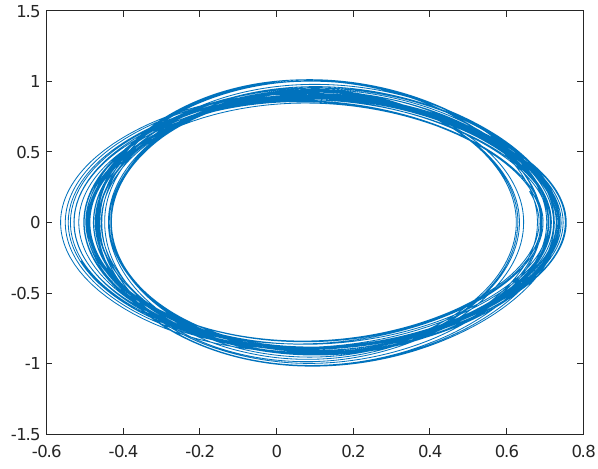
Figure 2. Phase portrait of (31) with (( u ( 0 ) , v ( 0 )) T = ( 0.66,0.22 ) T .